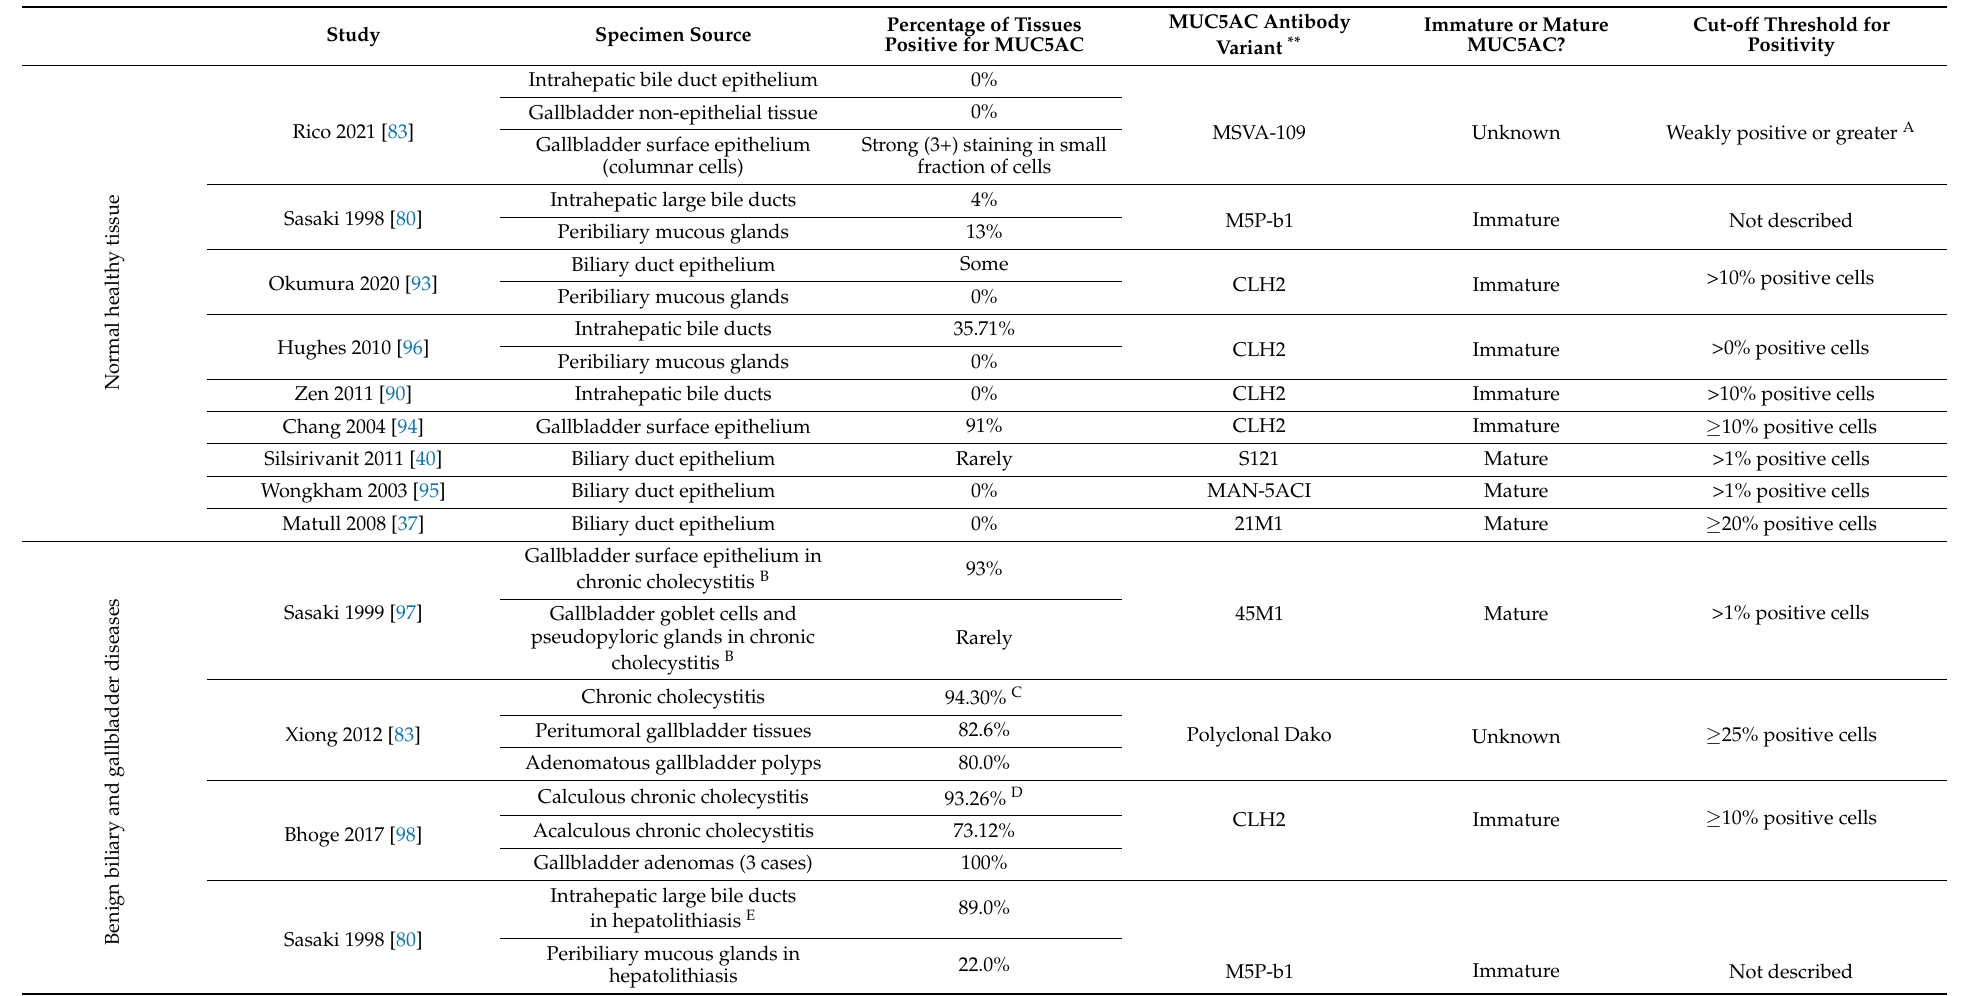
Table 1. MUC5AC tissue expression in normal biliary tissues, benign biliary diseases, and premalignant